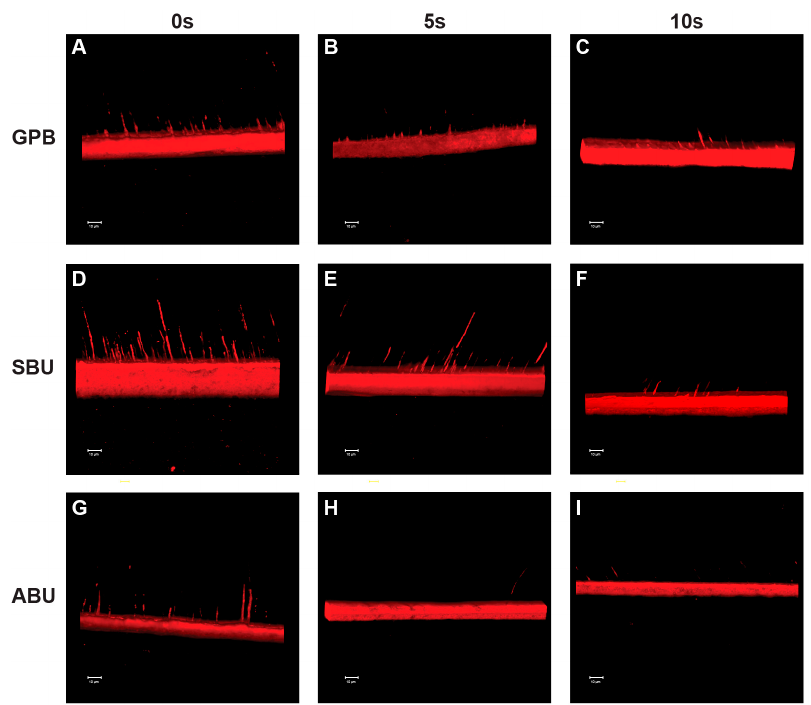
Figure 6. CLSM images of the universal adhesives interfaces in self-etch mode. ( A – C ) correspond to GB0, GB5, and GB10, respectively; ( D – F ) correspond to SB0, SB5, and SB10, respectively; ( G – I ) correspond to AB0, AB5, and AB10, respectively.